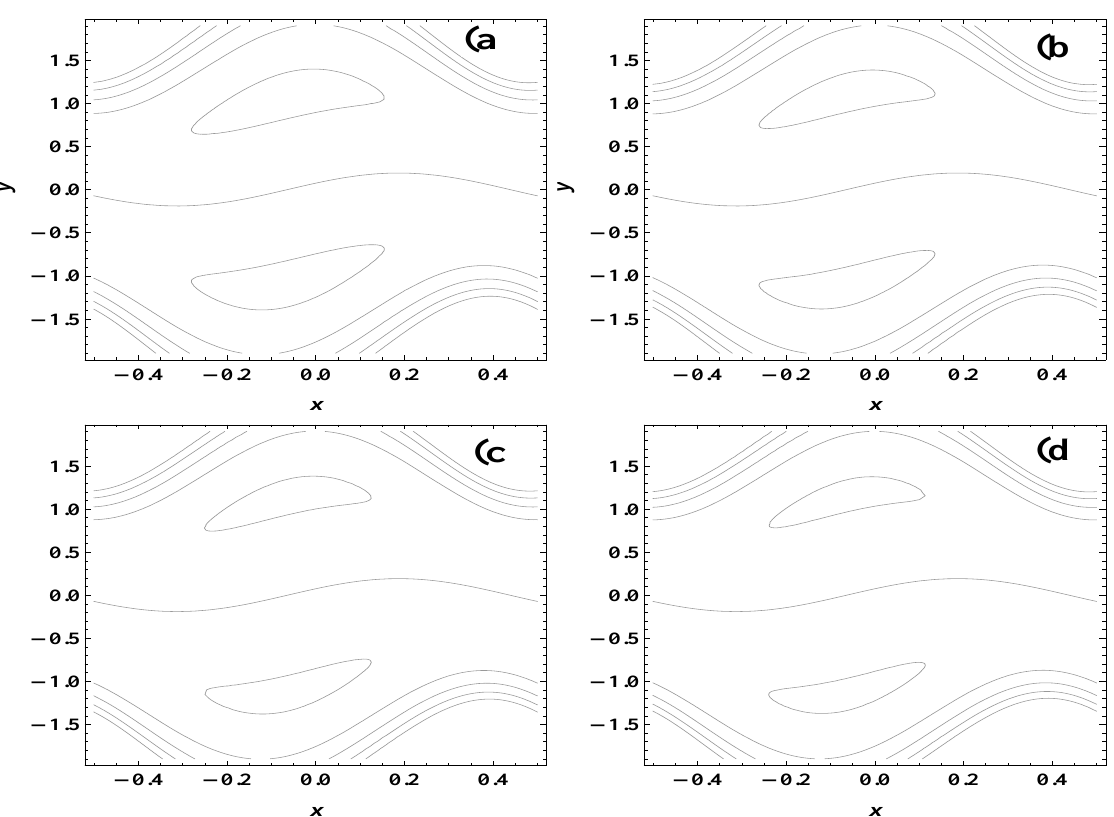
Figure 8. Influence of λ 1 on trapping with Q = 1.48, ϕ = π /4, M = 1 (a); λ 1 =0,(b); λ 1 =2,(c); λ 1 =3,(d); λ 1 =4.